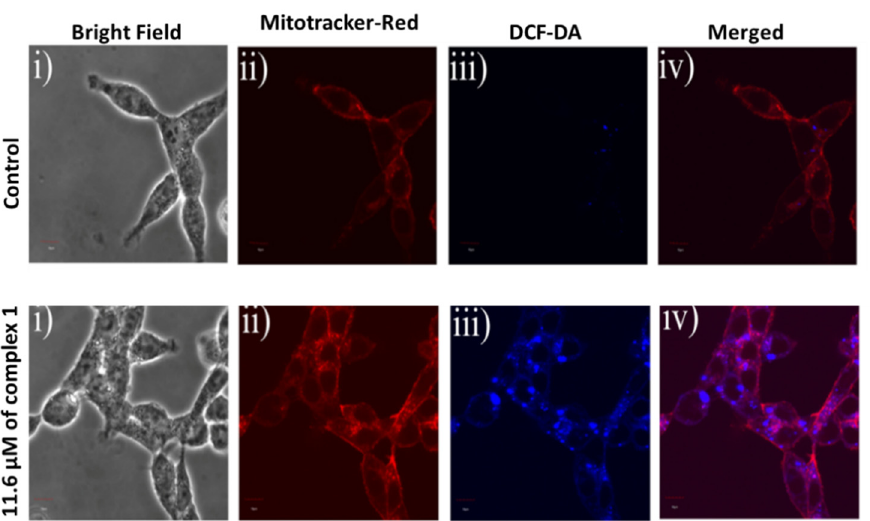
Figure 9. Measurement of mitochondrial ROS in HCT116 after 24 h of 11.6 μ M complex 1 treatment by confocal microscopy. Upper part showing i) bright field of control HCT116; ii) mitotracker red- stained image of control HCT116; iii) DCF-DA expression of control HCT116; iv) merged images of mitotracker red and DCF-DA in control HCT116. Lower part showing i) bright field; ii) mitotracker red; iii) DCF-DA expression; iv) merged images after 11.6 μ M complex 1 treatment.